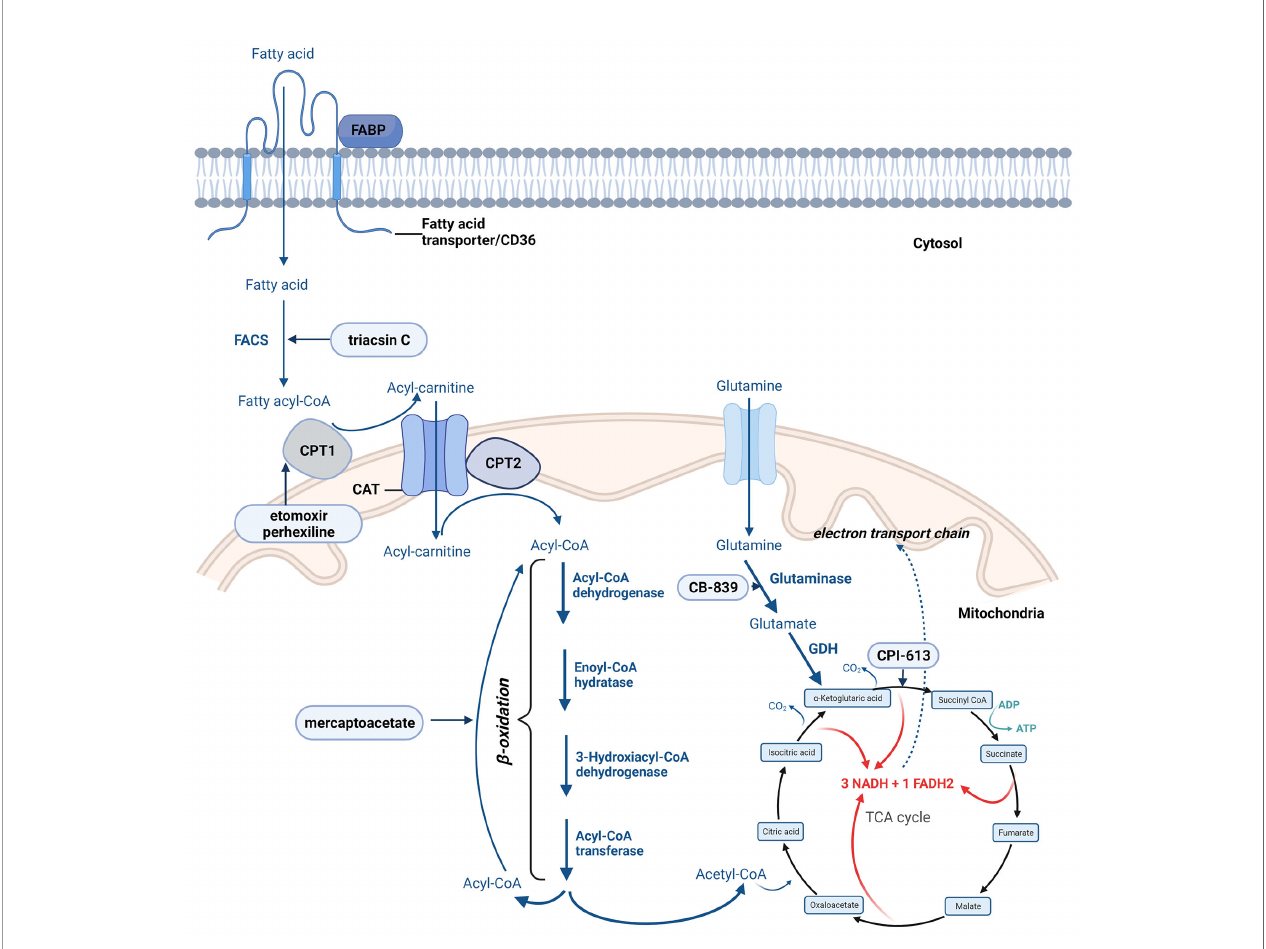
FIGURE 4 | The most important steps of fatty acid oxidation. Created with BioRender.com. Agreement number: